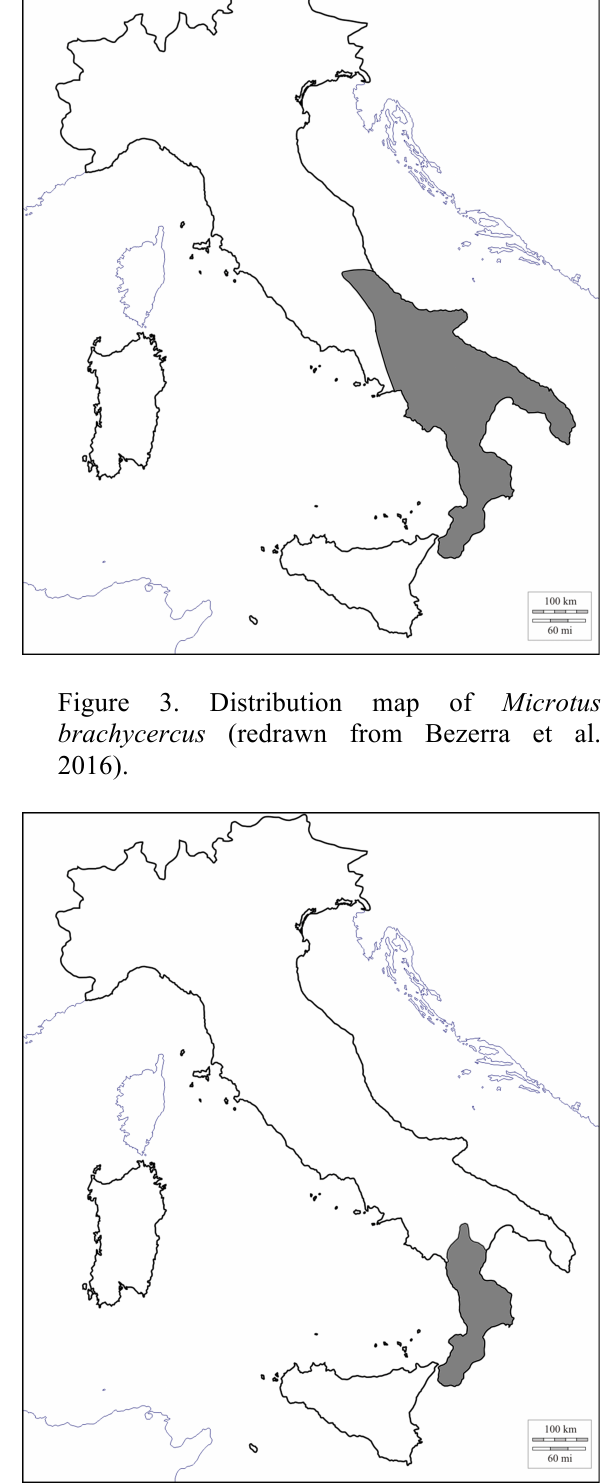
Figure 4. Distribution map of Sciurus meridionalis (redrawn from Wauters et al.